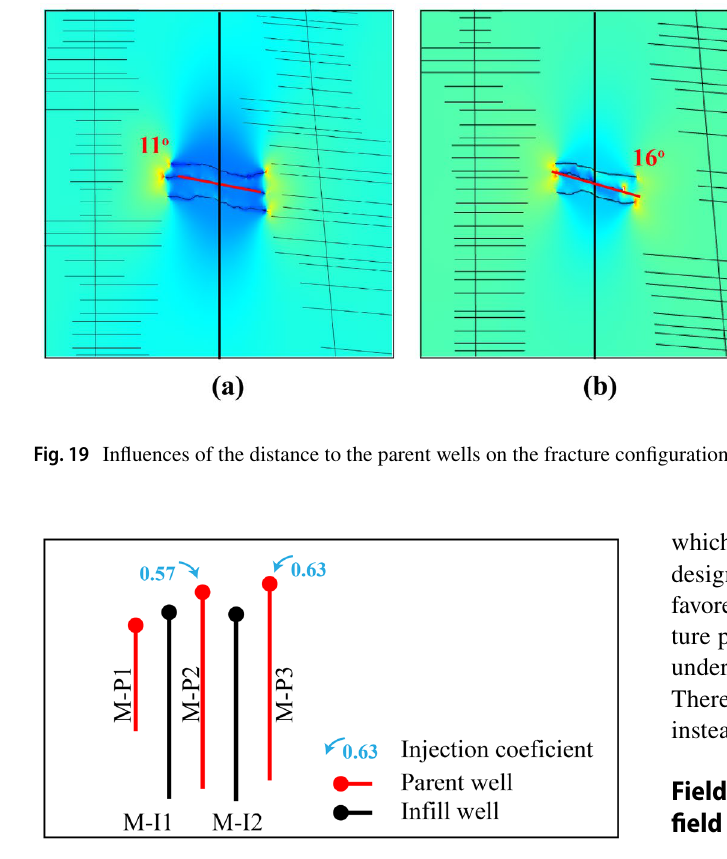
Fig. 20 Schematic diagram of the three parent wells and the two infill wells in the M region